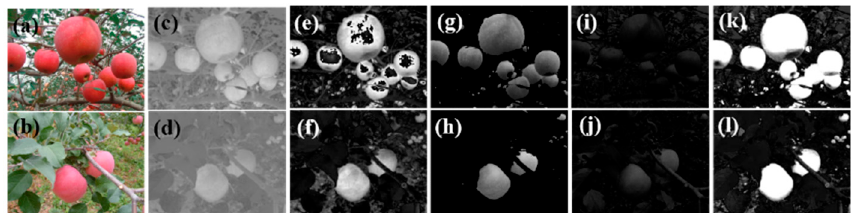
Figure 6. Comparison of various apple fruit detection algorithms. ( a , b ) Original image; ( c , d ) algo- rithm of [3]; ( e , f ) algorithm of [4]; ( g , h ) algorithm of [5]; ( i , j ) aCbR fusion space saliency results; ( k , l ) proposed method.